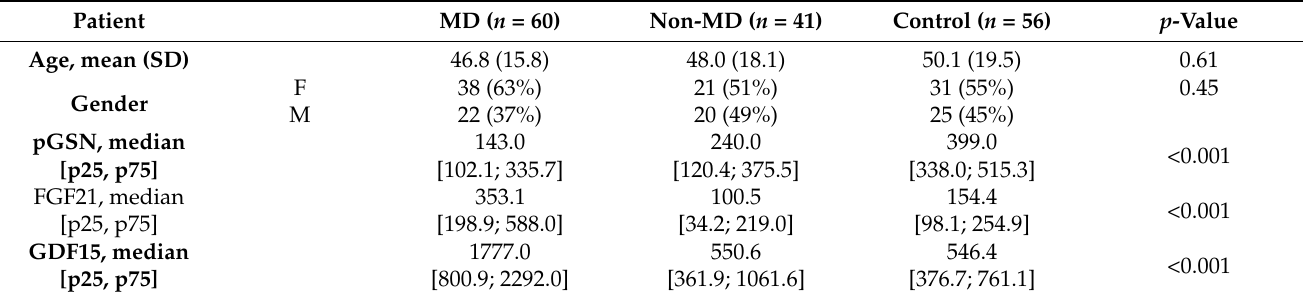
Table 1. Demographics and plasma levels of pGSN, FGF-21, and GDF-15 in the sample